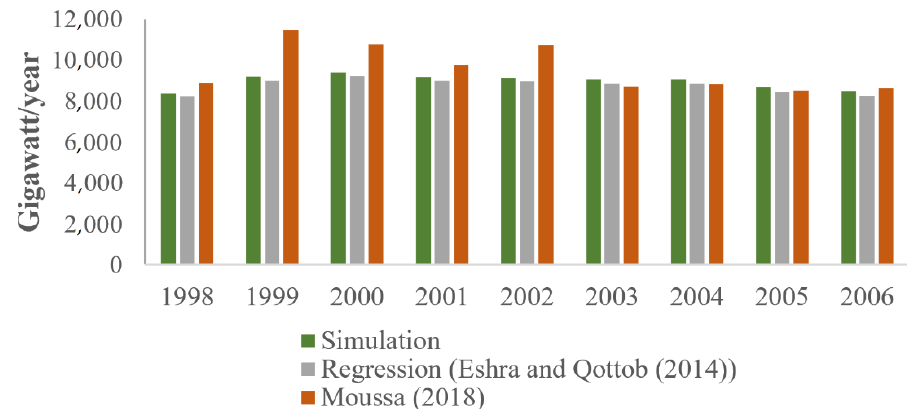
Figure 12. Annual hydropower generation.